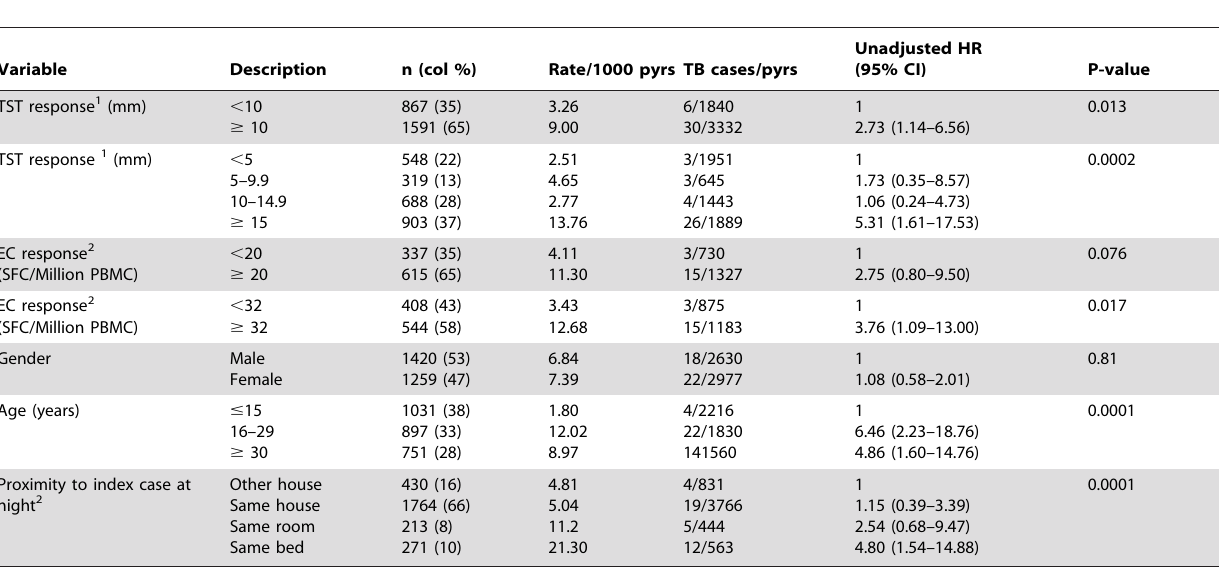
Table 4. Univariable analysis of time to TB episode; hazard ratios, 95% CI and P-values (n max =2679) - Definite TB cases only (n=40).